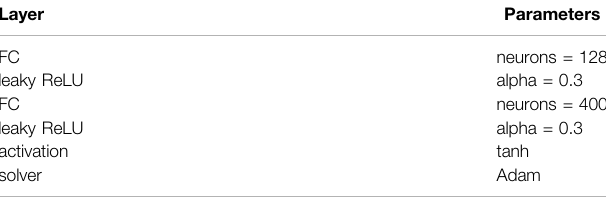
TABLE 1 | Summary of the parameters of the G.